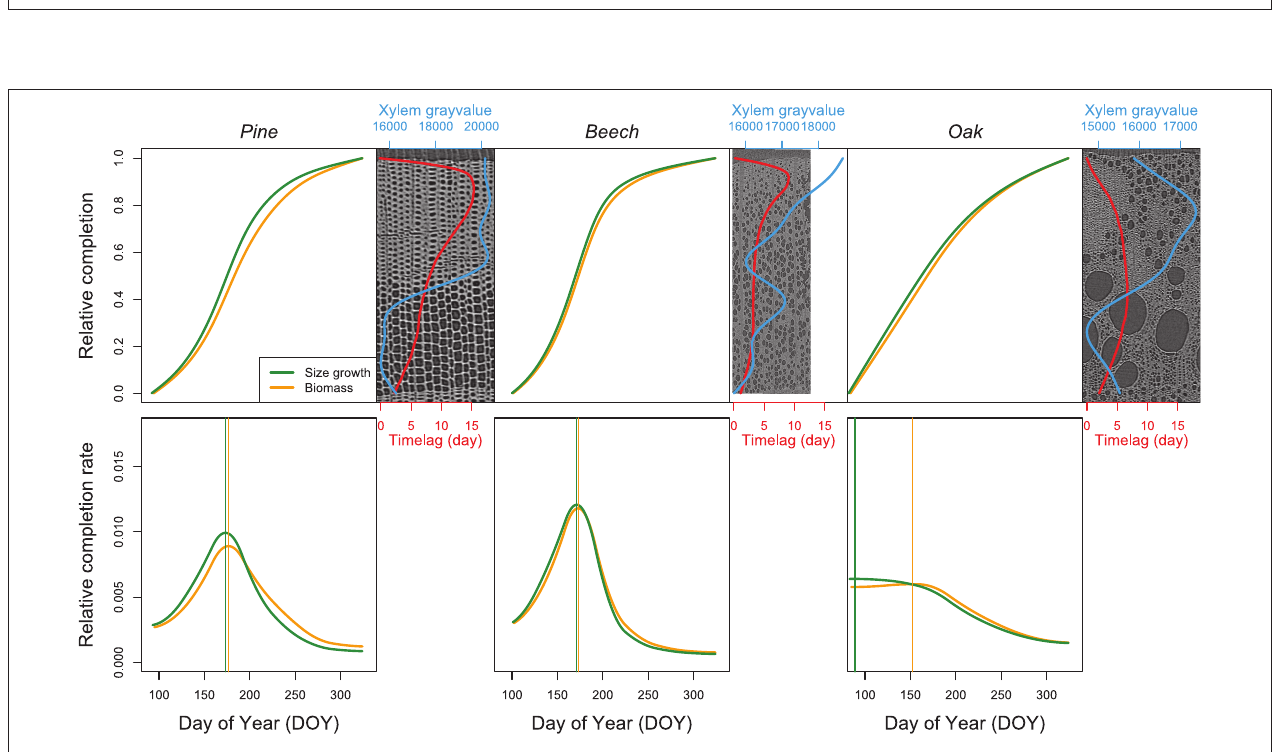
FIGURE 9 | Relative completion of size growth and biomass production. The top line presents the relative completion of size growth and biomass production during the growing season as well as the time lag between size growth and biomass production (red line). For each species, a reference image and its associated xylem gray-value profile (blue line) is shown. The bottom line presents the variation of the relative completion rate, with the vertical lines highlighting the DOY at which the maximum rate occurs.